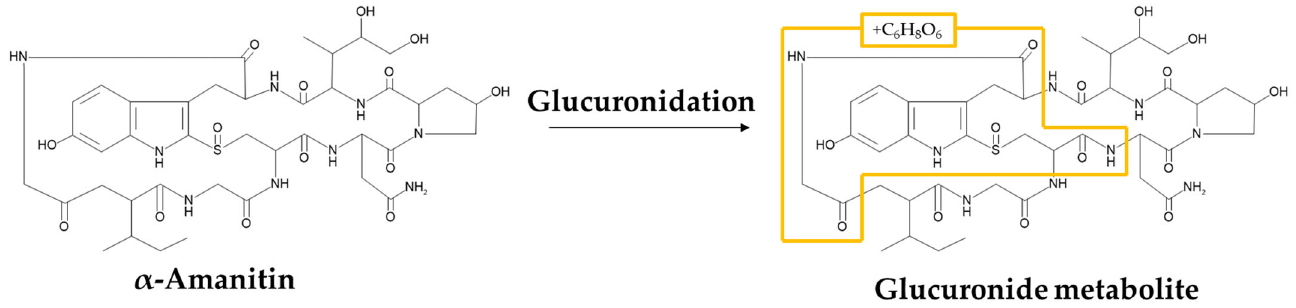
Figure 8. Metabolic pathways of α‐ amanitin under in vitro MetID (CLM and HLM). The total ion chromatogram (TIC) of parents and a proposed glucuronide metabolite of α‐ amanitin is shown in Figure 9.